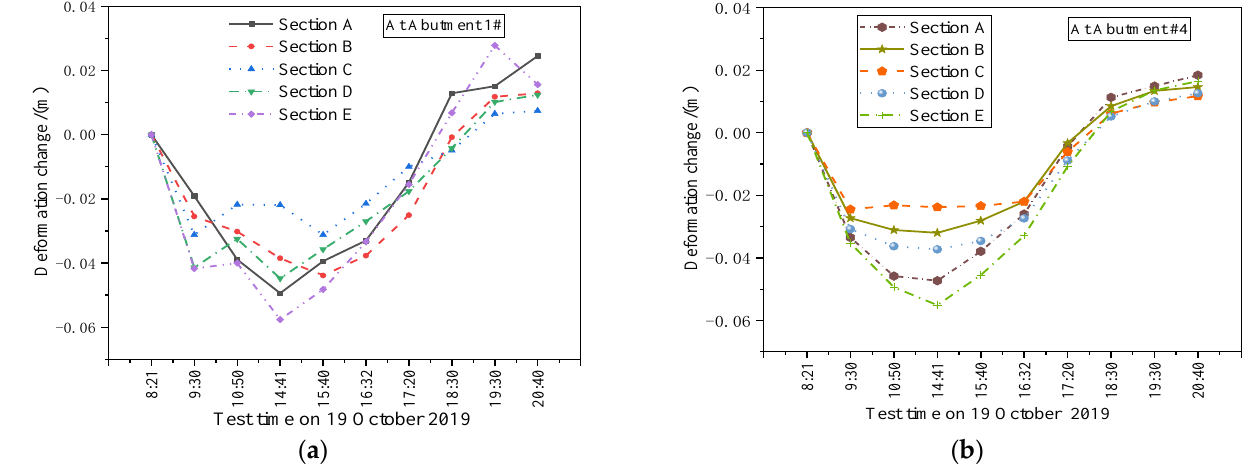
Figure 14. Results of elevation measurement at the end of the box girder at the abutment. ( a ) At abutment #1. ( b ) At abutment #4.